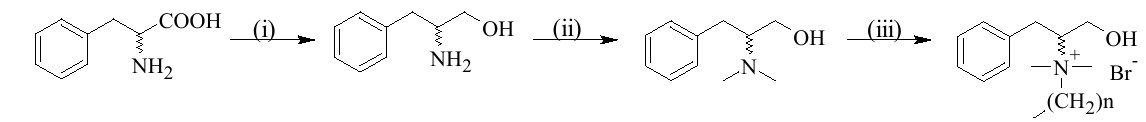
Figure 1. Synthesis of QUATs derived from phenylalanine. Reagents and conditions: (i) Na[BH HCOOH, reflux, 86 – 90%; 1-bromoalkane, CH